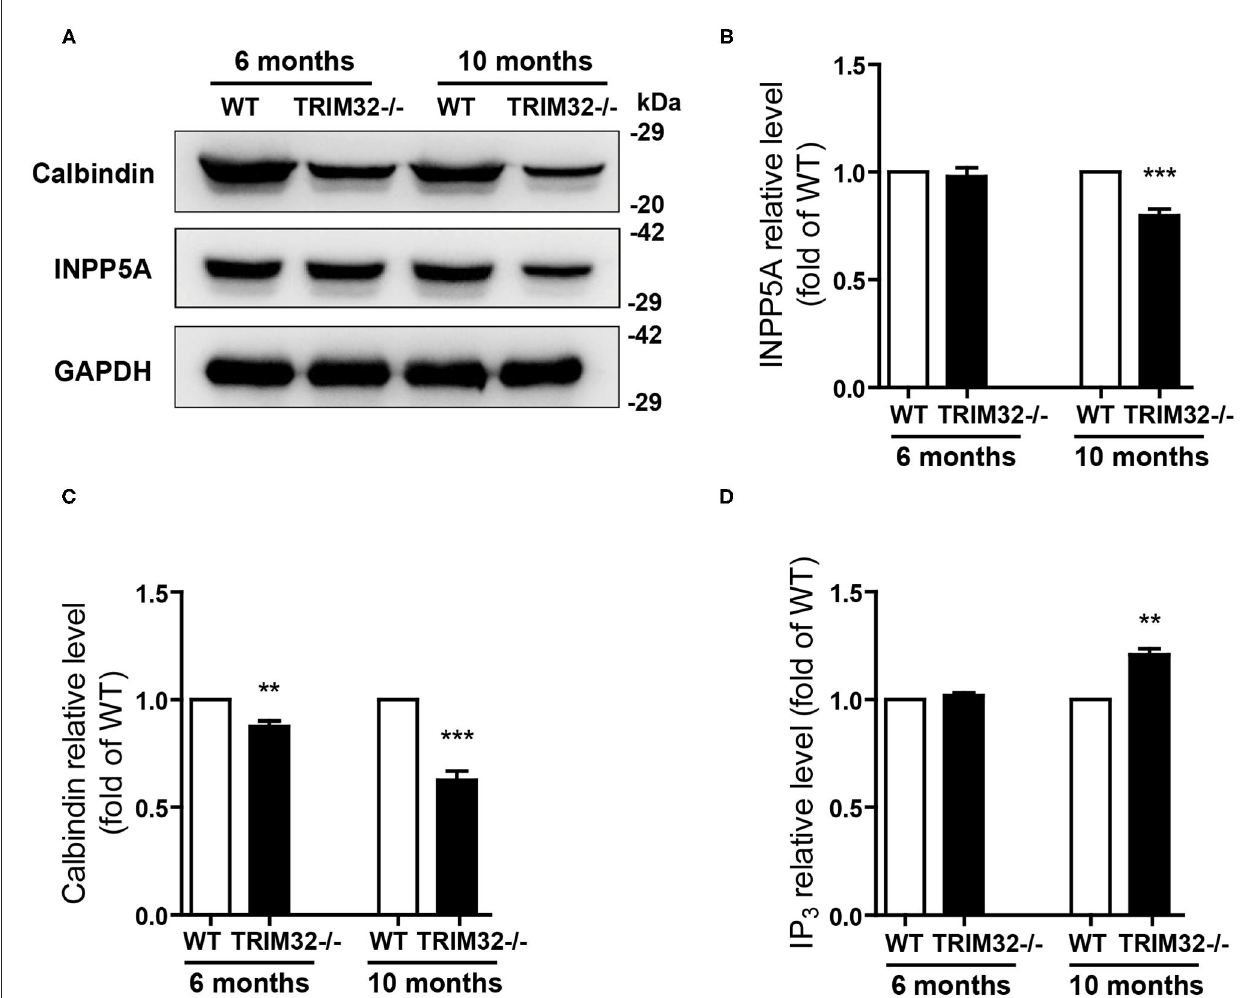
FIGURE 7 | Deficiency of TRIM32 changes levels of INPP5A and IP 3 . (A) Western blot analysis of levels of INPP5A and calbindin in TRIM32 − / – mice and their littermates. (B, C) Relative levels of INPP5A (B) and calbindin (C) were quantified. (D) ELISA assay analysis of level of IP 3 . Data are presented as mean ± SEM. n = 5 mice/genotype. ** p < 0.01, *** p <